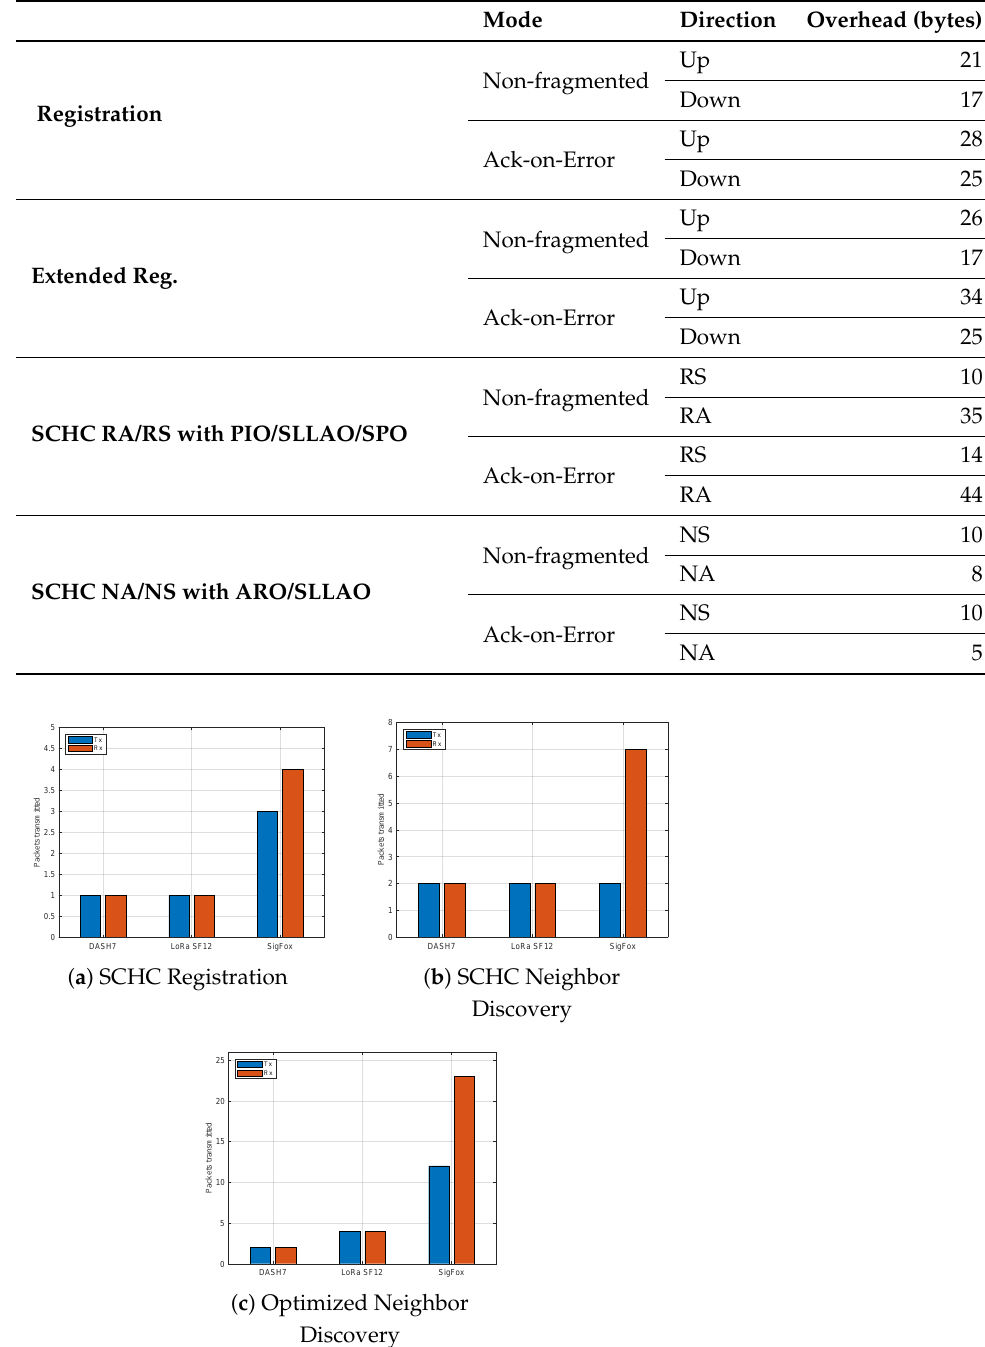
Figure 13. The total packet overhead for a single registration attempt using both registration mecha- nisms for different